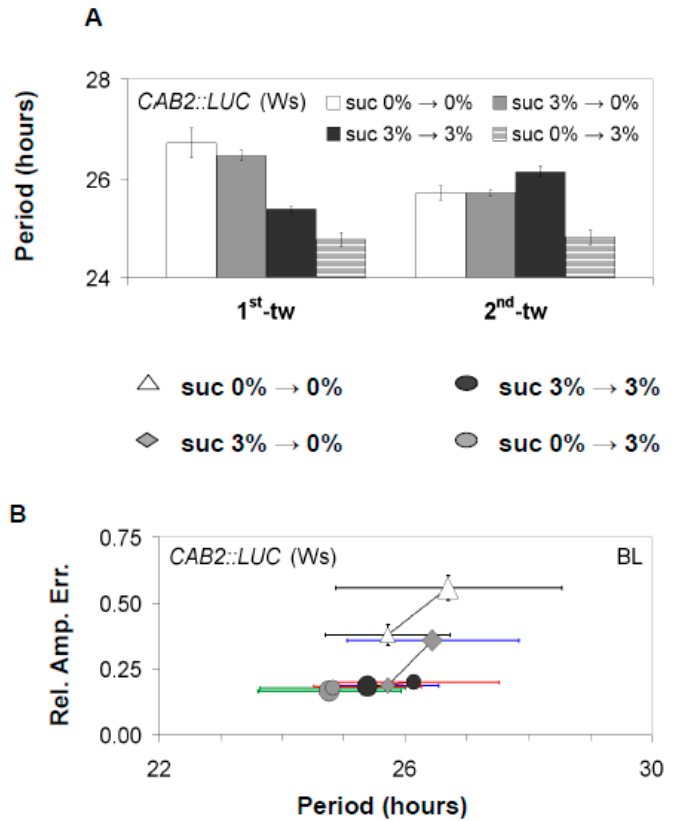
Figure 2. The effect of sucrose on rhythmic expression of the luciferase marker CAB2::LUC . C AB2::LUC (Ws-2) seedlings were either entrained in the presence or absence of 3% w/v sucrose and then moved to media with or without 3% w/v sucrose during free-running conditions (constant BL). ( A ) Analysis of periodicity in successive time windows of Ws-2 plants under different entrainment and free-running sucrose percentages. ( B ) As in Figure 1, the RAE and circadian period are paired for all plants that generated an FFT output (RAE < 0.9) under the different sucrose availabilities during entrainment or under free-running conditions. Error bars represent SE. FFT analysis was conducted as described in Figure 1 for the respective light conditions.